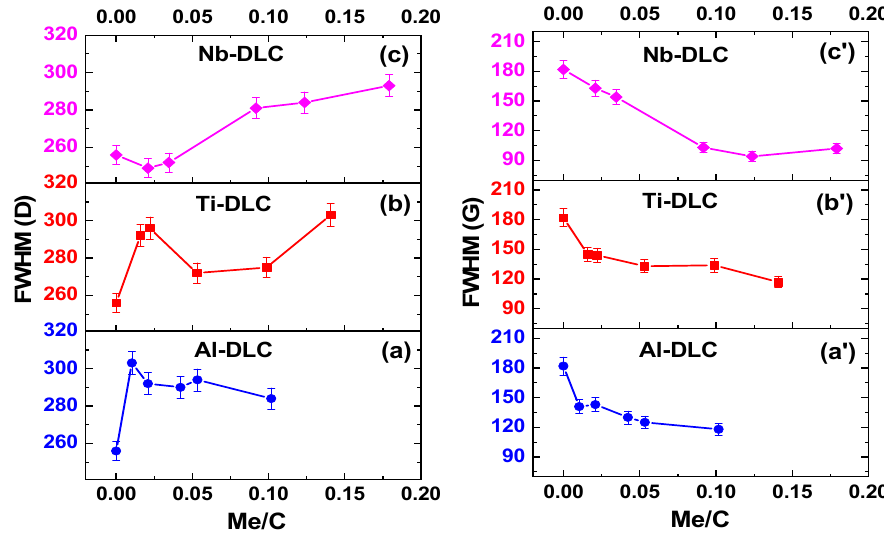
Figure 8. Evolution of Full Width at Half Maximum (FWHM) (D) and FWHM (G) as a function of Me/C of ( a , a’ ) Al-DLC, ( b , b’ ) Ti-DLC, and ( c , c’ ) Nb-DLC coatings, respectively.